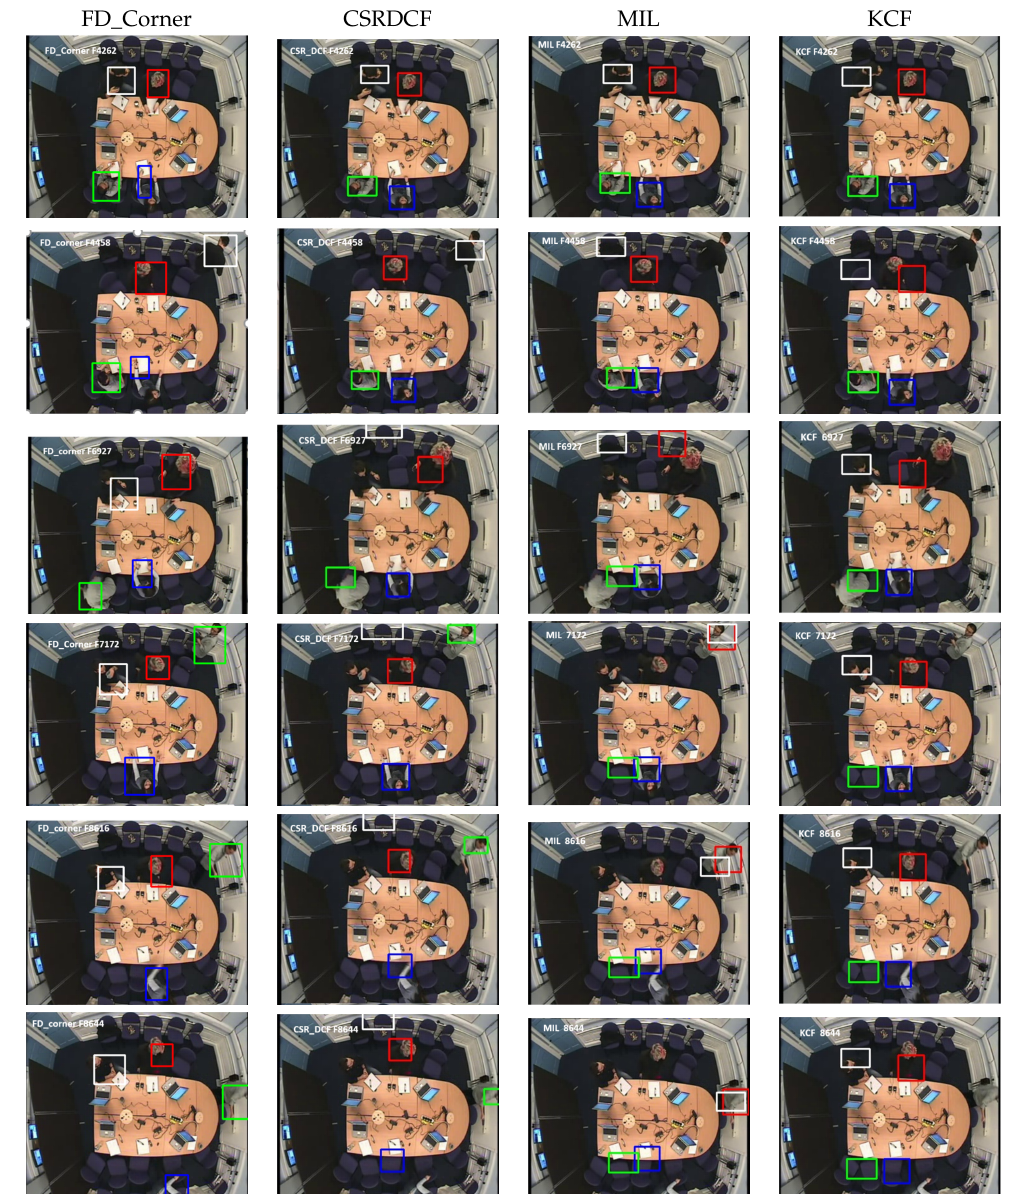
Figure 10. Qualitative evaluation of our approach FD_Corner in comparison with three baseline and state of art trackers on sequence 02 in terms of appearance change. Our tracker FD corner outperforms discriminative correlation filter with channel and spatial reliability (CSRDCF), Kernelized Correlation Filter (KCF), multiple instance learning (MIL) trackers in scenarios where people start moving in the meeting room and their appearance change significantly due to partial occlusion (person’s head out of camera